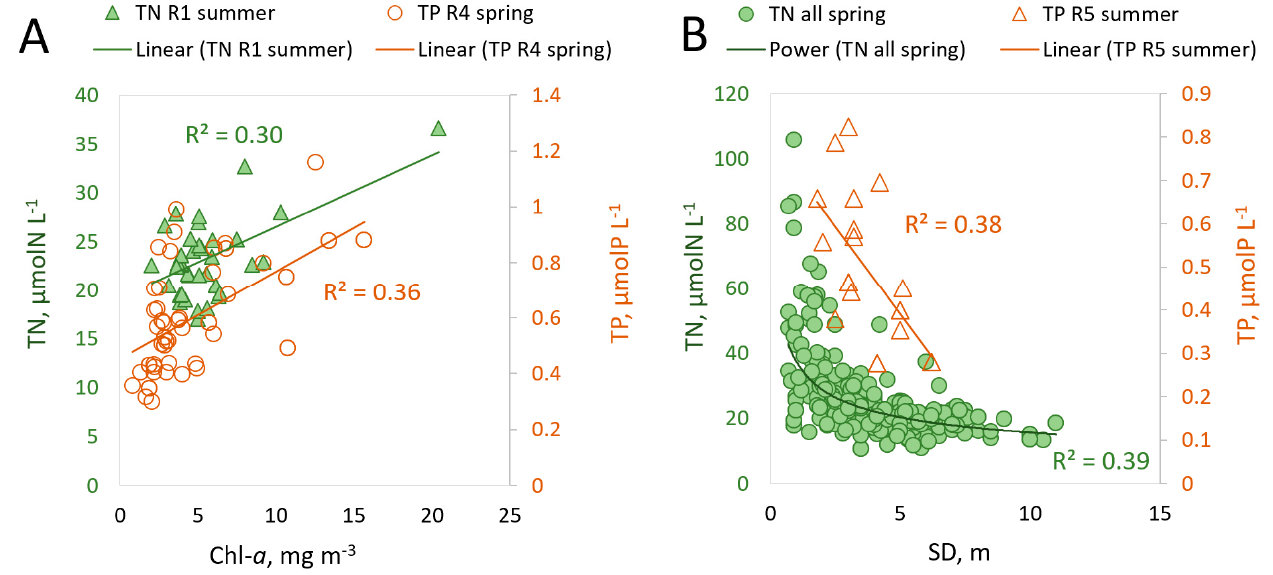
Figure 2. The strongest relationships of the in situ match-up dataset between the total nitrogen (TN) and total phosphorus (TP) and ( A ) chlorophyll- a concentration (Chl- a ), and ( B ) transparency of the Secchi disk (SD). Table 5. Determination coefficients ( R 2 ) of the linear regression, count ( n ) and the p -value ( p )